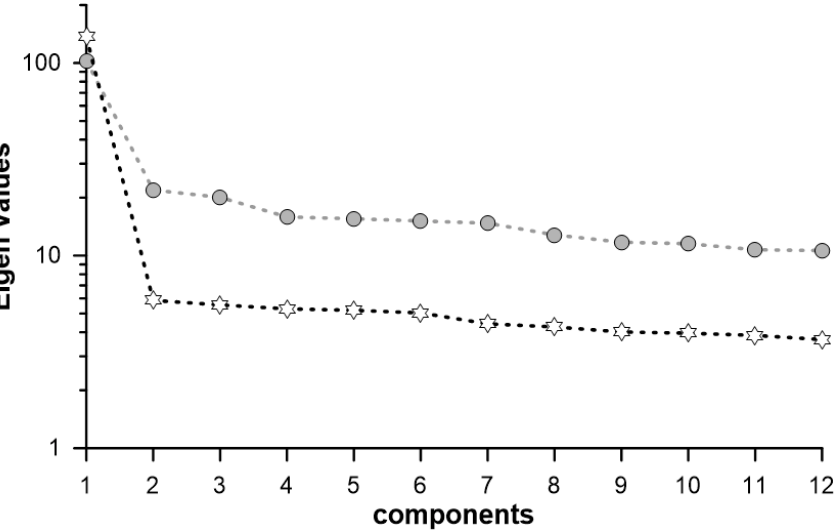
Figure 7. Eigenvalues plots of the first 12 components for the annual earthquake number series (cir- cles) and for the annual maximum magnitudes series (stars).